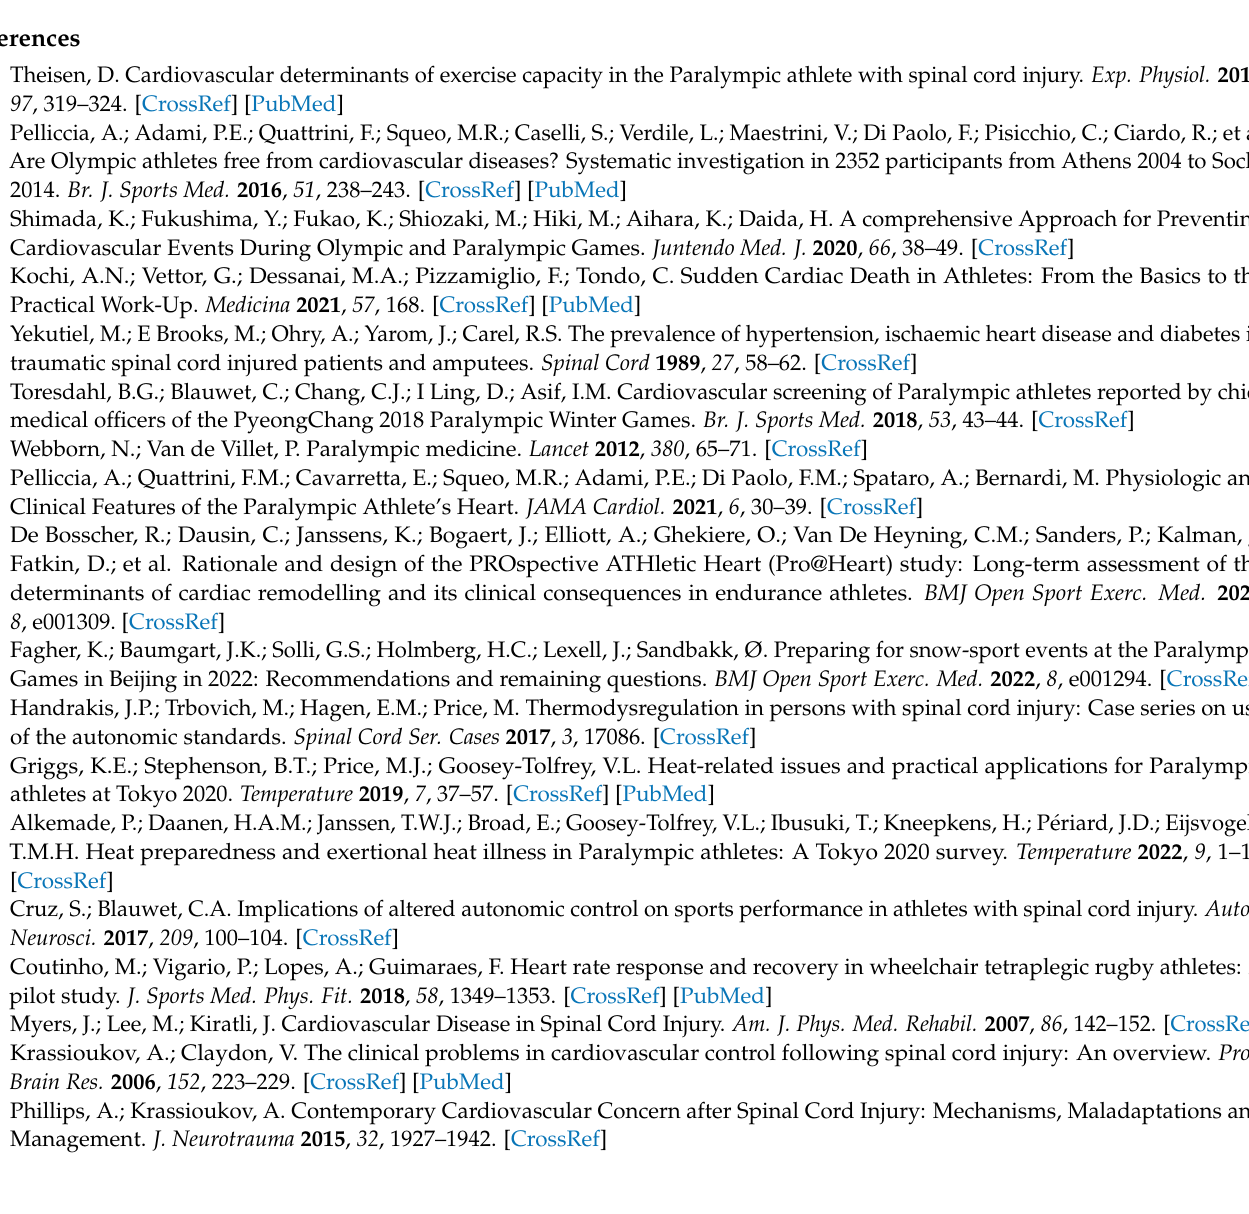
Table S3. Classification Systems used in Paralympic Summer; Table S4. Classification Systems used in Paralympic Winter